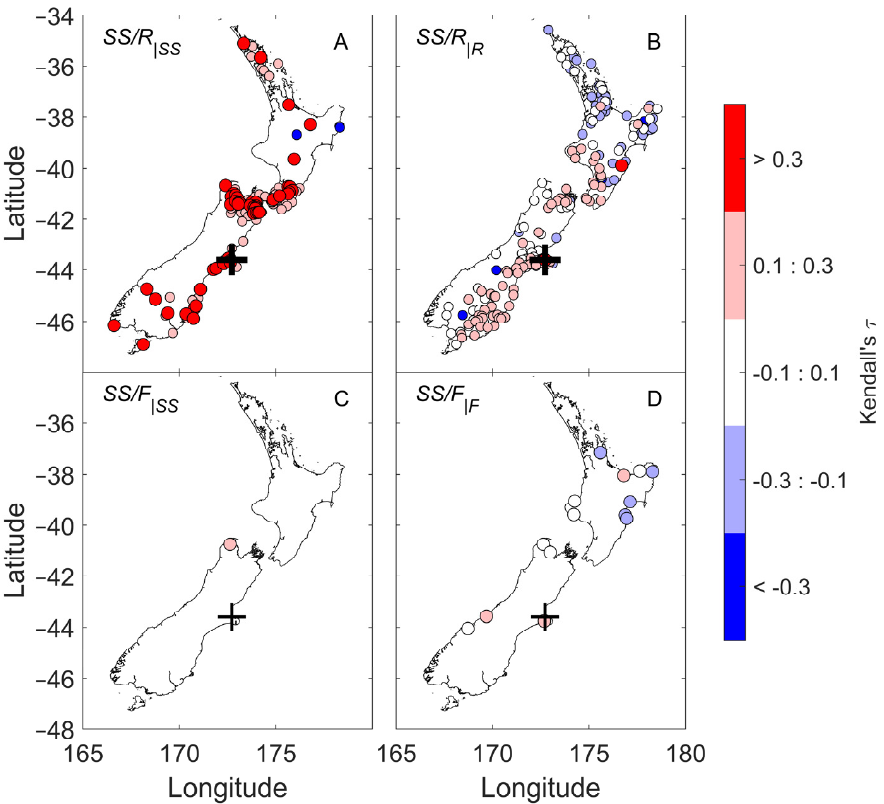
Figure 7. Kendall’s rank correlation coefficient τ (color scale) calculated between skew-surge mea- sured at Lyttelton and individual rainfall and river-flow records. ( A ) τ for skew-surge and rainfall, with rainfall conditional on extreme skew-surge; ( B ) τ for skew-surge and rainfall, with skew-surge conditional on extreme rainfall, ( C ) τ for skew-surge and river-flow, with river-flow conditional on extreme skew-surge, ( D ) τ for skew-surge and river-flow, with skew-surge conditional on extreme river-flow.